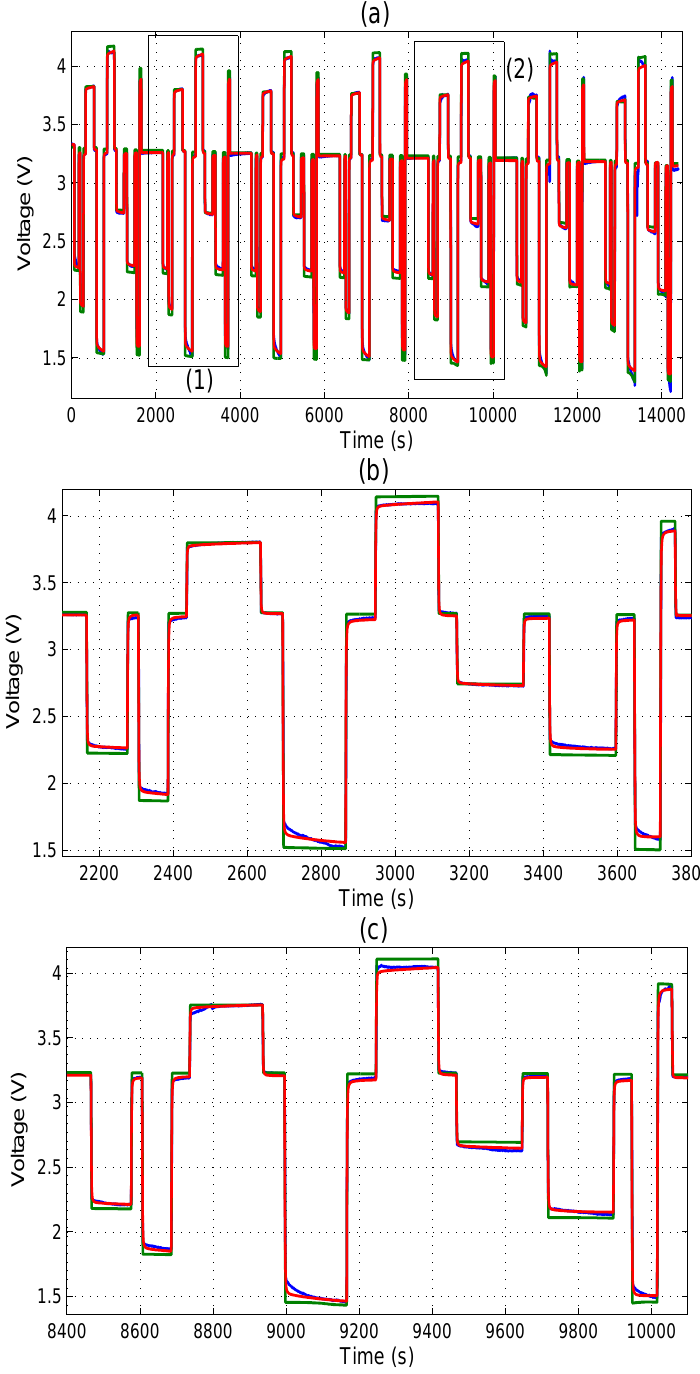
Figure 9. ( a ) Comparison of actual voltages of hybrid pulse test, 2 ‐ RC model output voltages and fractional ‐ order model output voltages for LiFePO4: all SOC range; ( b ) zoom ‐ in at Section 1; ( c ) zoom ‐ in at Section 2.